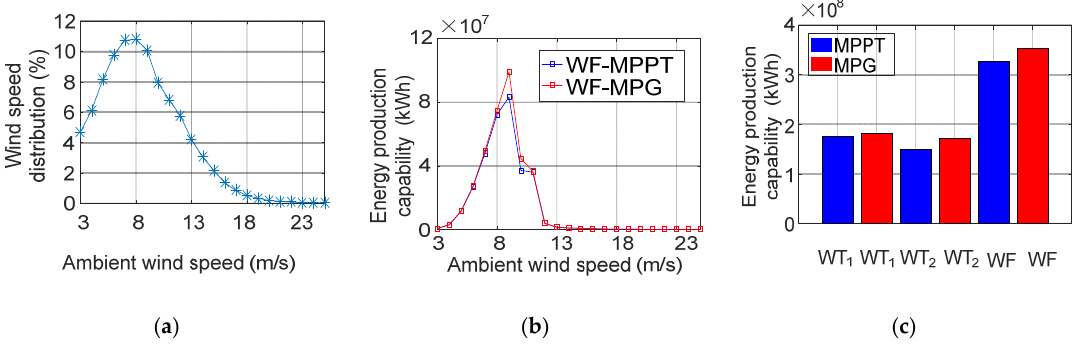
Figure 12. Energy production comparison between the MPPT method and the MPG method at the constant wind direction of 270°: ( a ) Field wind speed distribution; ( b ) Energy production of the wind farm at each ambient wind speed; ( c ) Total energy production of the wind farm at all ambient wind speeds.